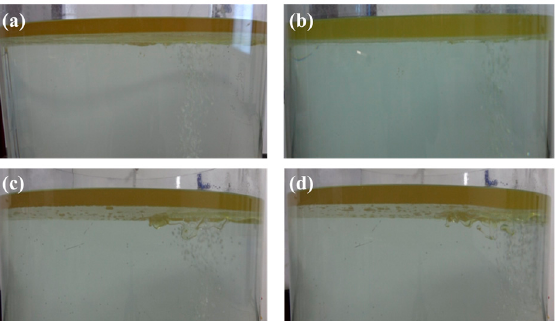
Figure 7. Slag entrapment behavior of single hole 2 and hole 3 under ( a , b ) 2.5 L/min, ( c , d ) 3.8 L/min bottom blowing flow.